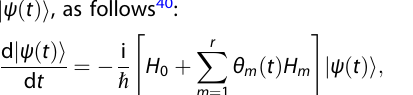
(cid:2) (cid:3) (cid:2) . Subsequent inference control pulses θ ð k Þ are updated for the next iteration according to In